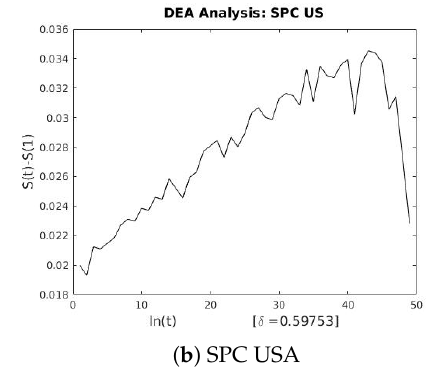
Figure A6. DEA for SP500 and SPC